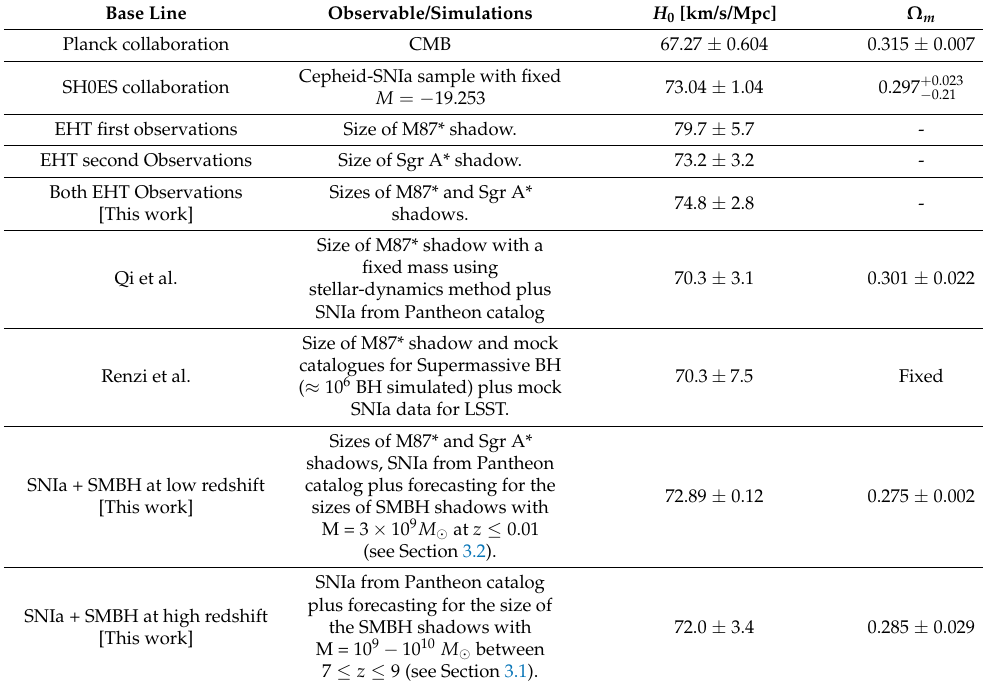
Table 2. Compilations of results for ( H 0 , Ω m ) constraints. The first column denotes the baseline and its references (data from [1,8,9,11,14,28], respectively). The second column indicates the observ- able/simulations treated in each baseline. The third and fourth columns indicate the ( H 0 , Ω m ) values obtained from each analysis, respectively. Our results are indicated in the last two rows. In addition, we denote as Fixed when the baseline is considered flat prior to the parameter at hand, Not reported when the parameter was not computed, and a dashed line (-) indicates a not related constraint since it was estimated at low